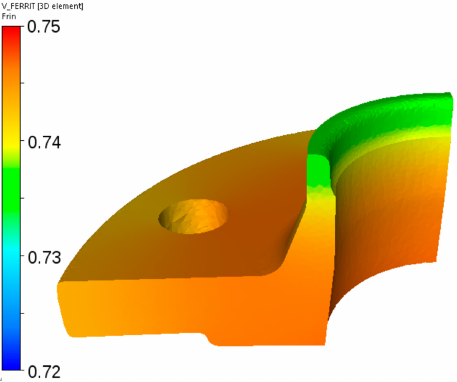
Figure 21. Calculated distributions of the ferrite volume fraction after cooling of the flange from steel B according to the schedule in Figure